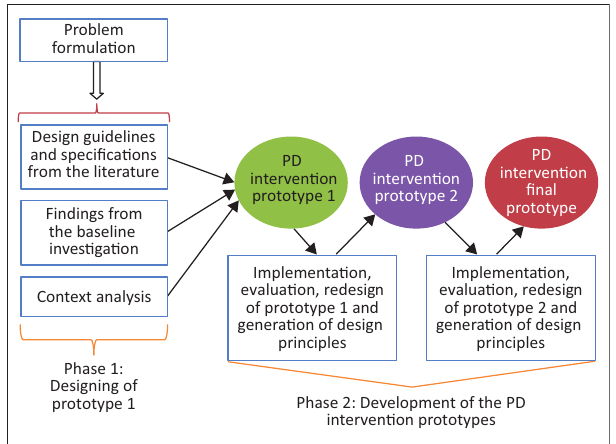
FIGURE 1: The research design of the study.